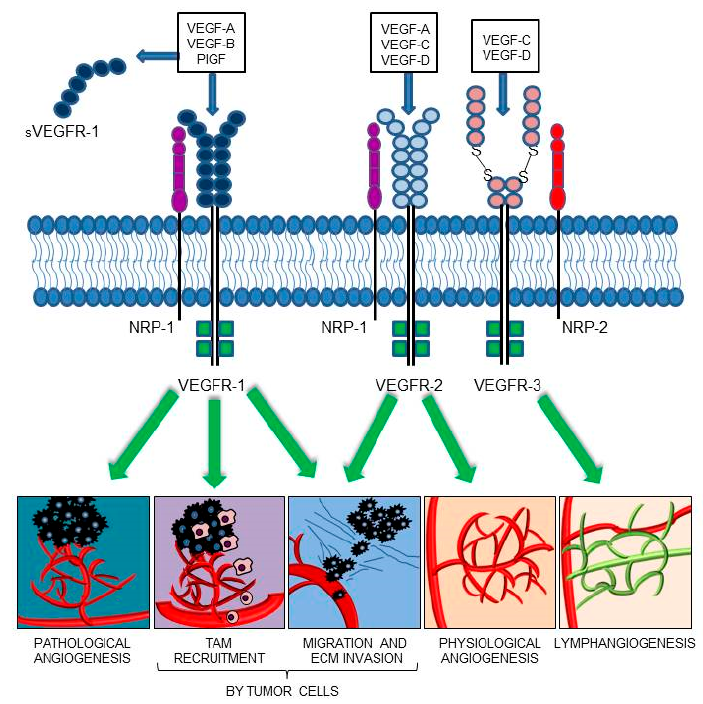
Figure 1. VEGF family members and their receptors. VEGF-A proangiogenic signaling is mediated via interaction with VEGFR-2 or VEGFR-1. The soluble VEGFR-1 form (sVEGFR-1) functions as a decoy receptor, preventing membrane receptor activation. VEGF-B and PlGF only bind to VEGFR-1, playing a key role in pathological angiogenesis and inflammation. Furthermore, VEGFR-1 activation contributes to the recruitment of tumor-associated macrophages (TAMs) and cancer immune escape. VEGFR-1 and VEGFR-2 activation in tumor cells directly stimulates migration and extracellular matrix (ECM) invasion. VEGF-C and VEGF-D mainly activate VEGFR-3, which is required for developmental and pathological lymphangiogenesis. The VEGF-E, a selective VEGFR-2 ligand, and VEGF-F, a VEGFR-1 and VEGFR-2 ligand, have been omitted from the drawing; VEGF-E is a VEGF homolog of viral origin and VEGF-F is a snake venom VEGF.